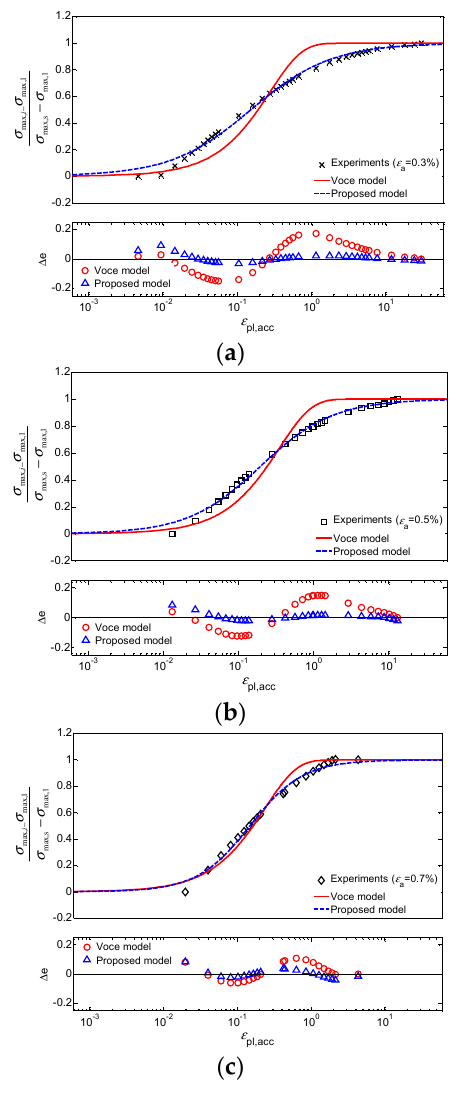
Figure 5. Isotropic model for different strain amplitudes (( a ) ε a = 0.3%, ( b ) ε a = 0.5% and ( c ) ε a = 0.7%); Voce model (red solid line) and proposed model (blue dashed line). Residual ∆ e is also reported.